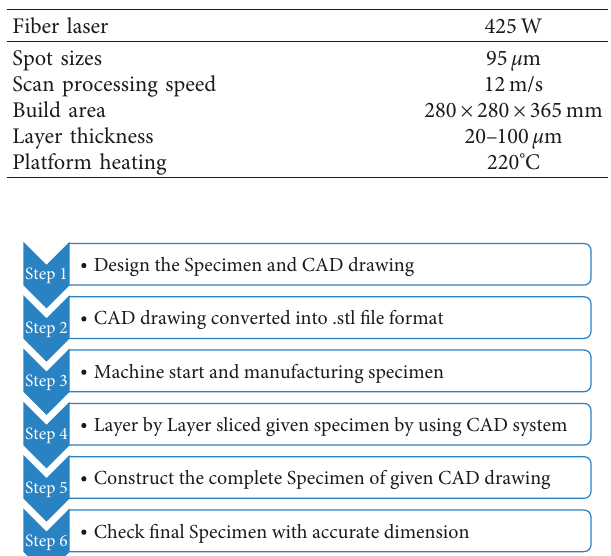
Figure 1: The SLM experimental setup. Table 1: The list of SLM process machine specifications and laser process parameters.